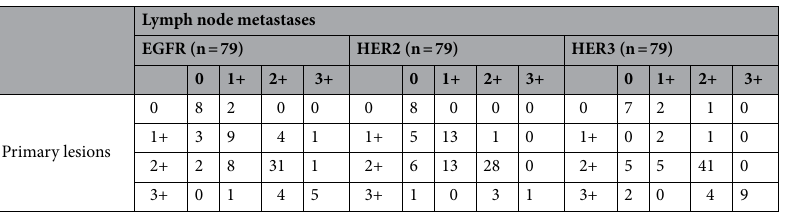
Table 2. EGFR, HER2, and HER3 immunohistochemistry scores of primary lesions and lymph node metastases of CRC.